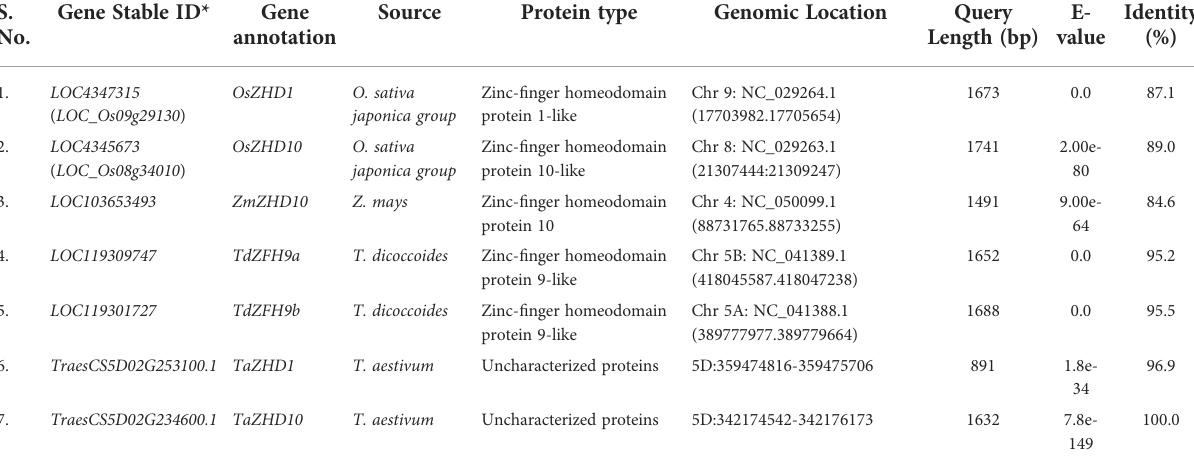
TABLE 1 Identi fi cation of candidate genes putatively involved in leaf rolling in wheat and their orthologs. S.